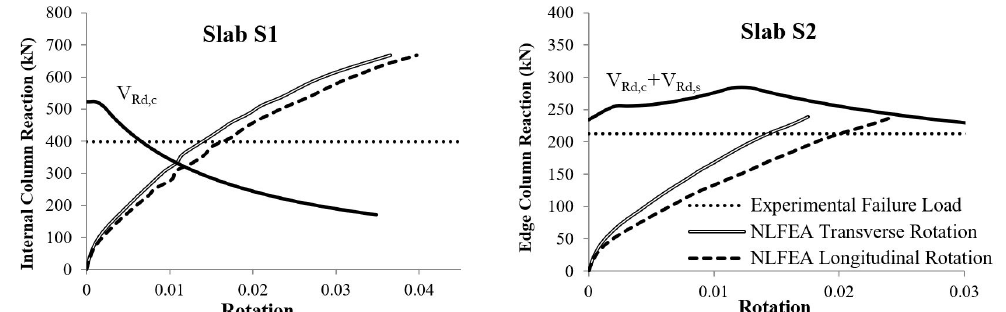
Figure 7.C olumn reaction-rotation relative to the column for the slabs of Sherif and Dilger [6] and resistance according to the CSCT.